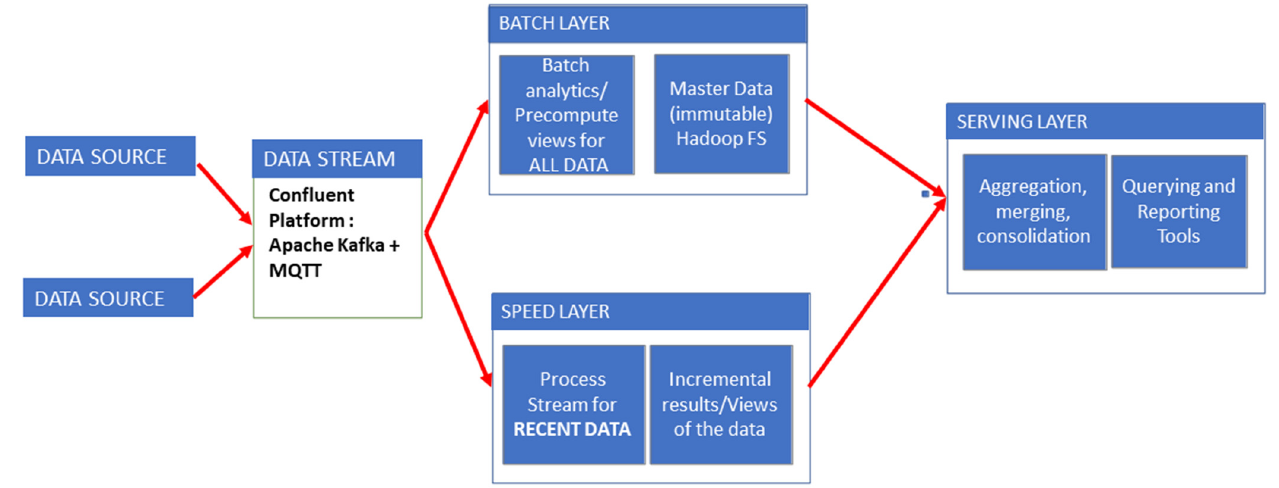
Figure 5. The components of the Lambda architecture.